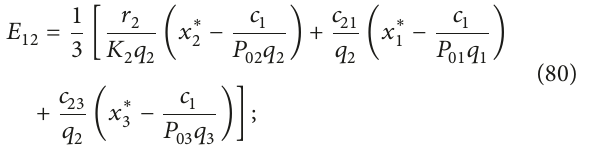
Table 2: Economic parameters of the model.